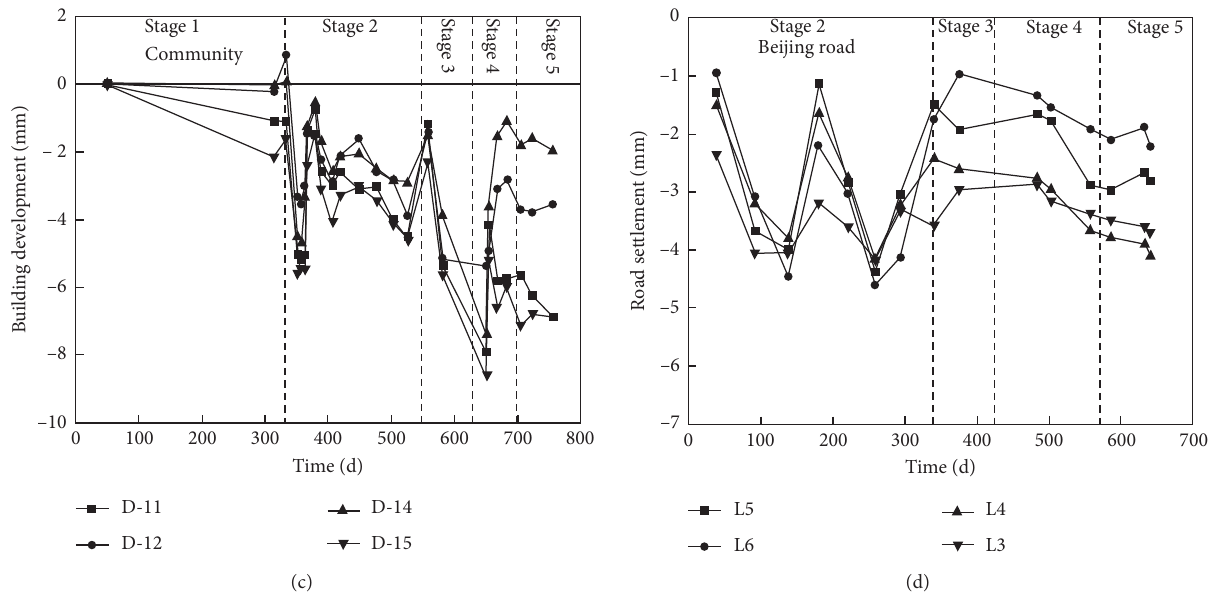
Figure 9: Settlement of (a) apartment; (b) bank; (c) community; and (d) Beijing road.